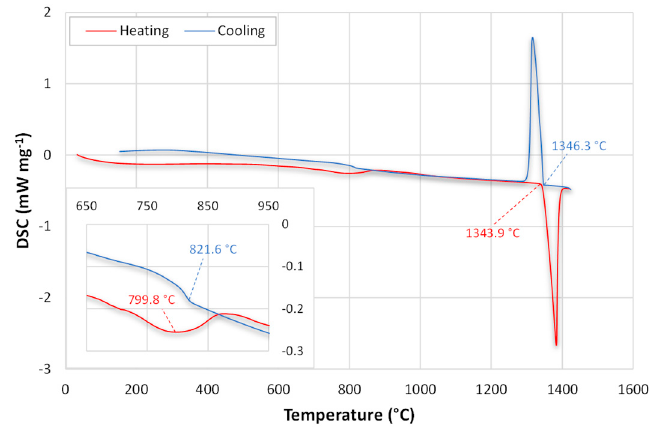
Figure 1. Heating and cooling curves from DSC analysis on the AlCoCrFeNi 2.1 CCA.